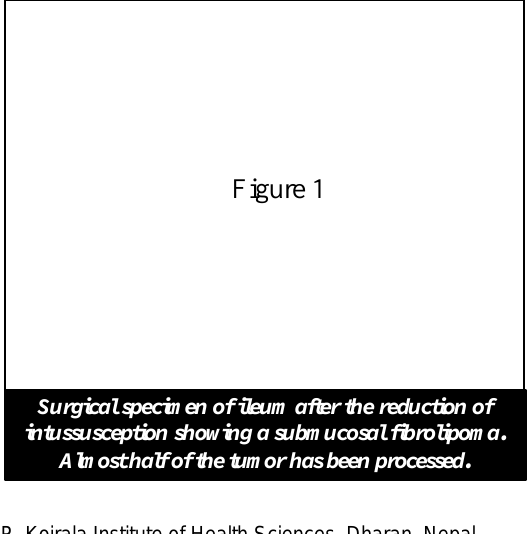
Surgical specimen of ileum after the reduction of intussusception showing a submucosal fibrolipoma. Almost half of the tumor has been